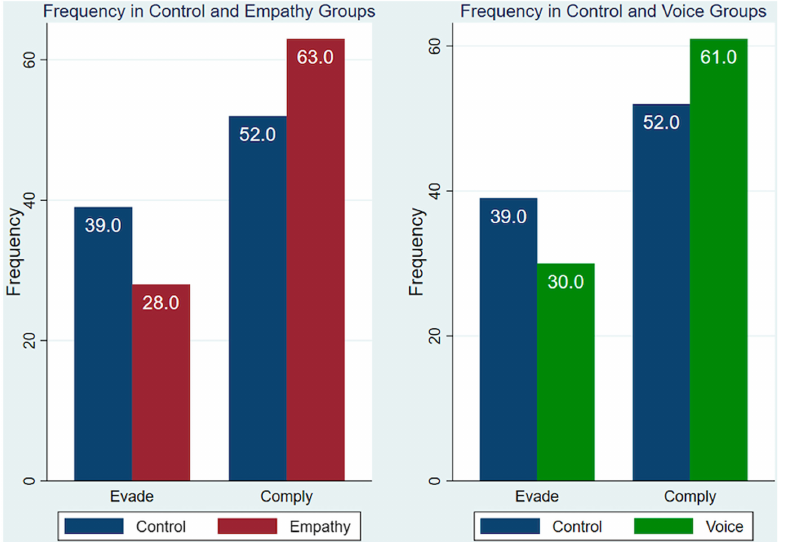
Figure 1. Frequency